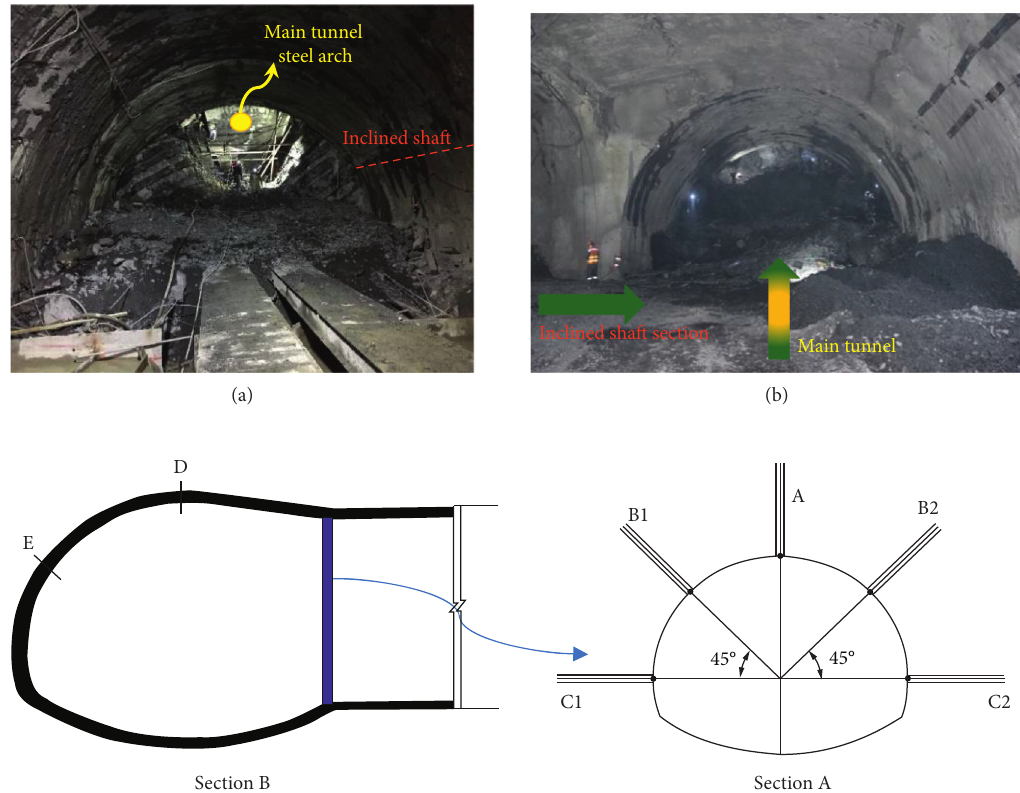
Figure 27: Construction of intersection and monitoring points: (a) the inclined shaft into the main tunnel and (b) the main tunnel driving.